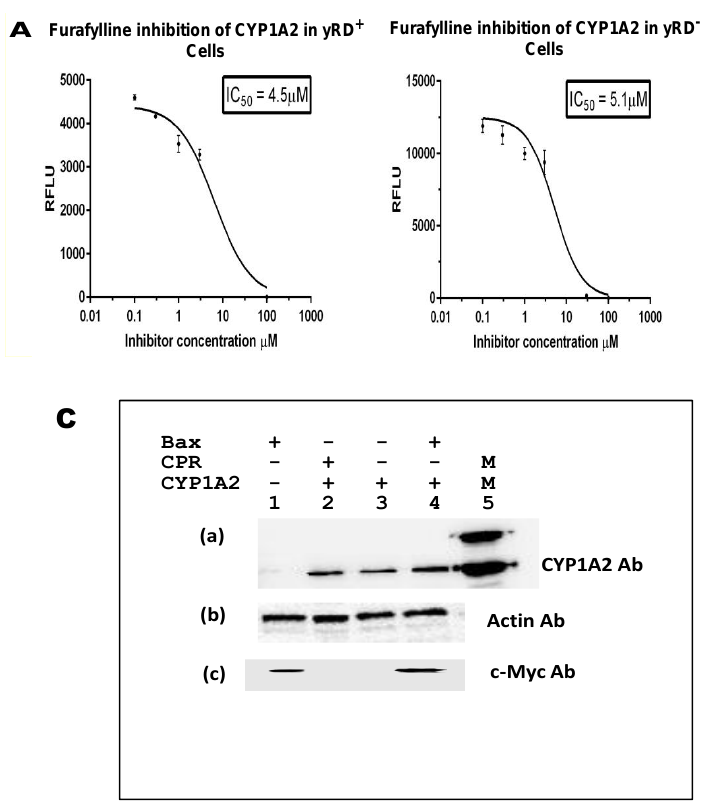
Figure 6. IC 50 of Furafylline for the inhibition of CYP1A2 enzyme expressed within yRD + and yRD − :: Bax cells. Furafylline’s IC 50 for inhibition of CYP1A2 enzyme was expressed within whole cells. The cells that were used were from strains ( A ) yRD + (+CPR) and ( B ) yRD − :: Bax (–CPR) were transformed with an episomal plasmid encoding a CYP1A2 gene expression cassette, CYP1A2 enzyme expression was driven by the ethanol-inducible ADH2 promoter (ADH2p). In yRD − cells, Bax expression was driven by the GAL1 promoter (GAL1p), which was de-repressed in ethanol. Recombinant cells were grown for 18 h in YPD liquid medium containing glucose, allowing for around 6 h of induction and de-repression of ADH2p and GAL1p in ethanol (it takes ~12 h for glucose to be utilized and converted completely to ethanol). Cells were harvested and washed in PBS-saline. The assay included 1 × 10 7 washed cells and 3-cyano-7-ethoxycoumarin (CEC) as a substrate. Each point represents the mean of triplicate readings; bars denote ± standard deviation. The x -axis represents the values of the concentration of furafylline in µM (ranges from 0.1 to 100 µM) that were incubated with cells for 10 min, the y -axis relative fluorescence units of the fluorescent product formed. The IC 50 values were calculated using the GraphPad Prism software. Furafylline’s IC 50 for inhibition of CYP1A2 Supersomes (insect cell-derived CYP1A2-bearing microsomes; Corning-Gentest), with a 10 min incubation with a microsomal enzyme, is 6.1 µM [36,37]. ( C ) Western Blotting of lysates from yRD + , yRD − , and yRD − :: Bax cells expressing CYP1A2. Yeast cell lysates (5 µg of total cellular protein for monitoring CYP1A2 and actin; 50 µg for Bax) fractionated on SDS/PAGE and probed with antibodies to CYP, Bax, and actin proteins after Western blotting. (aCell lysates probed with a CYP1A2 antibody (Proteintech, 19936-1-AP). Lane 1, BC600:: GAL1p-Bax (lysate from untransformed cells, which did not contain CYP1A2 episomal plasmid, as negative control). Lanes 2-4: cell lysates from the strains BC300, BC600, and BC600:: GAL1p-Bax transformed with an episomal plasmid that contained a CYP1A2 gene expression cassette under the control of the ADH2 promoter. Lane 2, BC300:: CYP1A2, lane 3, BC600:: CYP1A2, lane 4, BC600:: Bax,CYP1A2, and lane 5, 1.5 pmole of microsomal CYP1A2 (as positive control; CYP Design Ltd.). ( b ) Lanes 2-4, as in ( a ), probed cell lysates with an actin antibody (Proteintech, 60008-1-Ig). ( c ) Lanes 2-4, same as in ( a ), the cell lysates being probed with a c-myc antibody tagged to the human Bax protein (Thermo Scientific, MA 1-980).